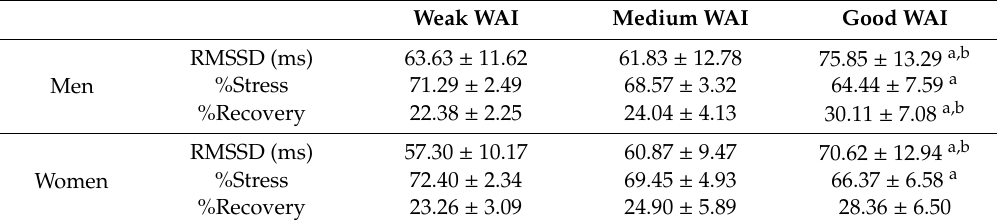
Table 3. Di ff erences in RMSSD, %Stress and %Recovery in the di ff erent WAI